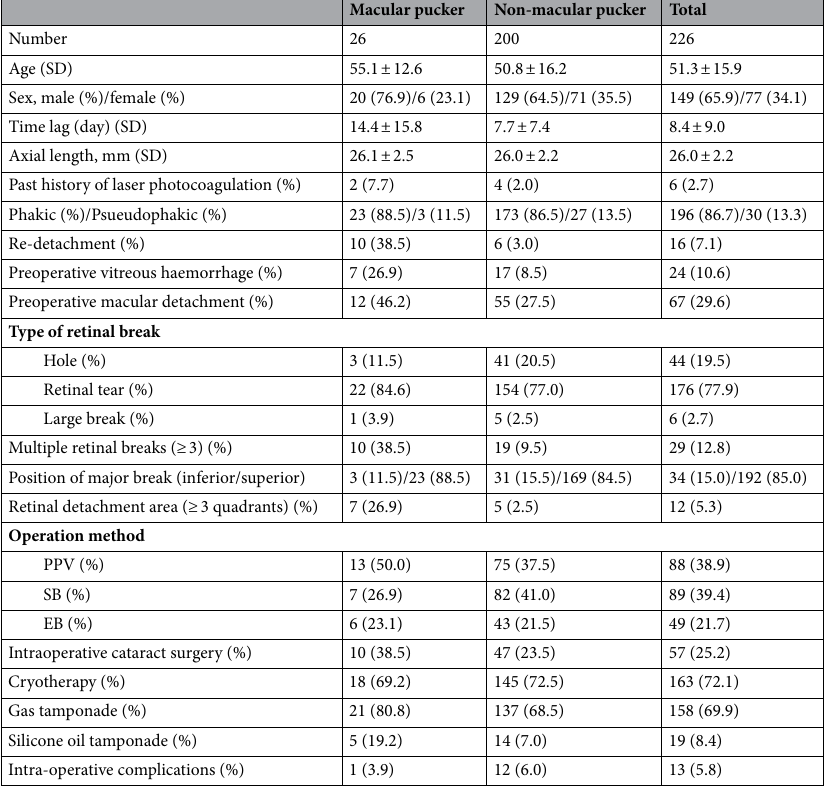
Table 1. Demographic and baseline clinical characteristics of patients undergoing RRD surgery. EB, encircling buckle; IOL, intra ocular lens; PPV, pars plana vitrectomy; RRD, rhegmatogenous retinal detachment; SB, segmental